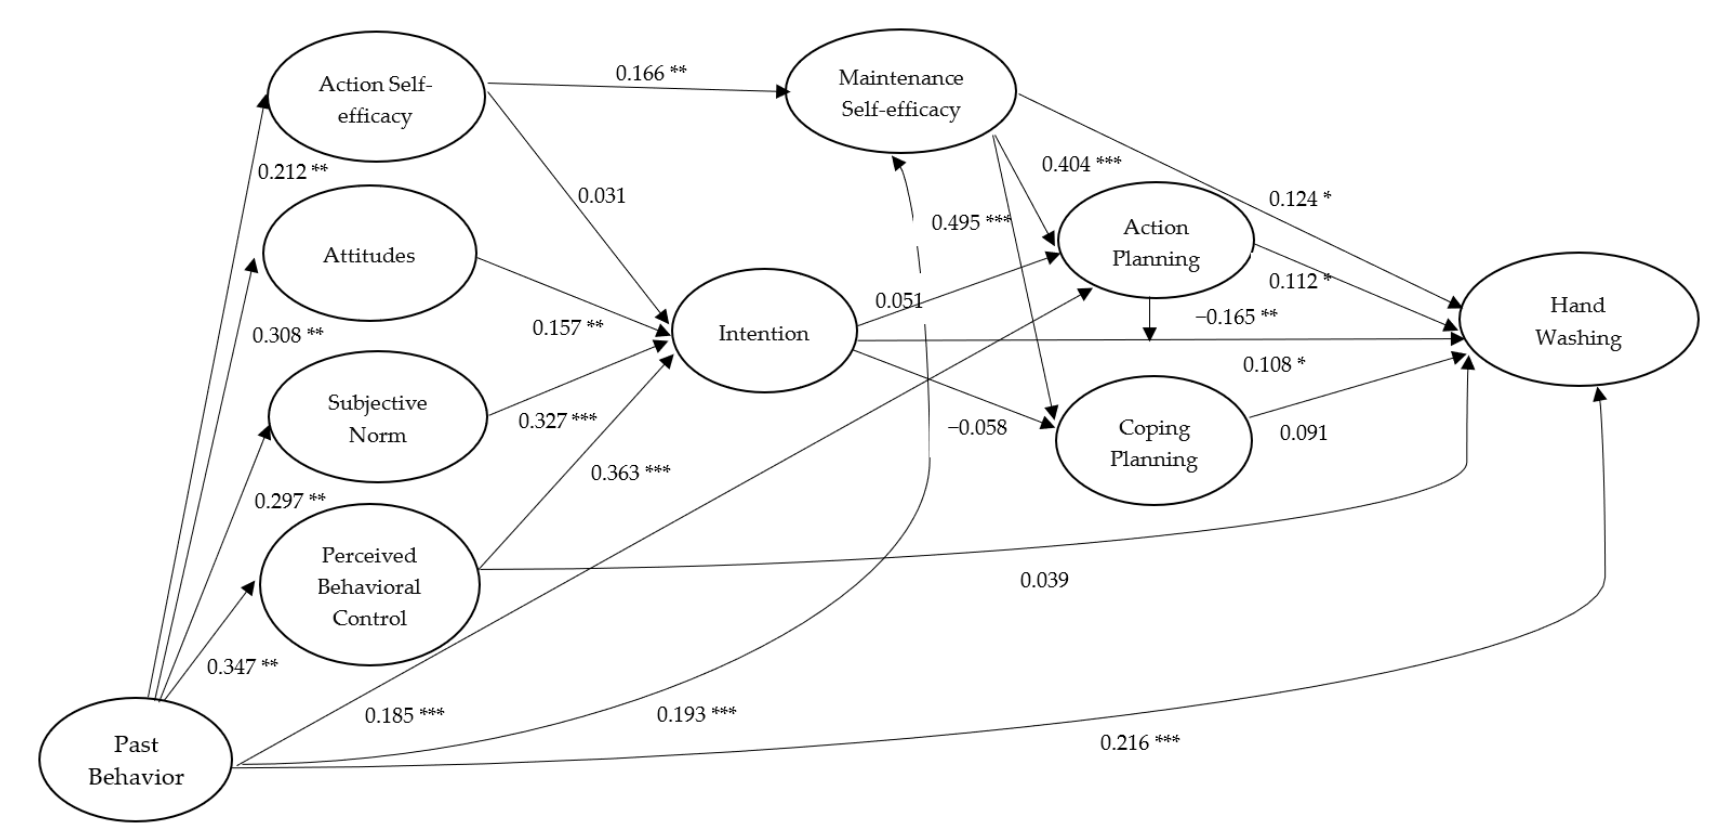
Figure 3. Standardized path coefficients of the Integrated Social-Cognition Model for hand washing including past behavior. Note. College students’ age and gender were controlled. All hypothesized effects among the psychological and behavioral variables were proposed to be positive in direction. Only significant effects from past behavior to psychological variables were displayed. * p < 0.05; ** p < 0.01; *** p < 0.001.